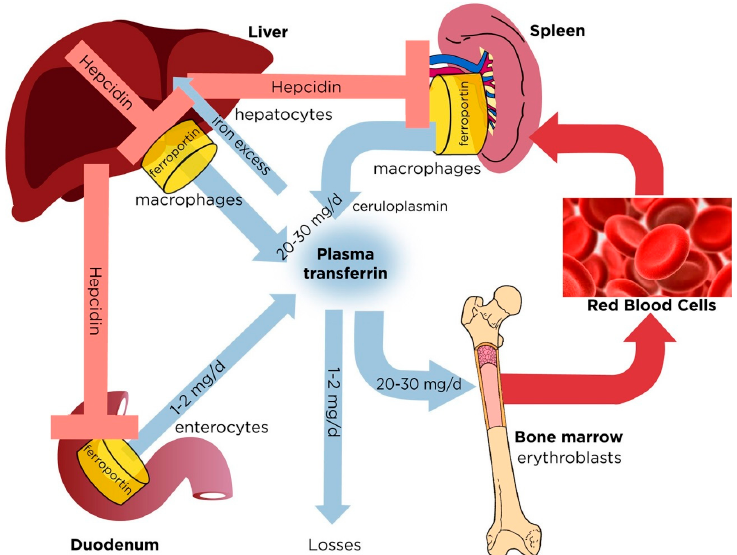
Figure 1. Dynamics of systemic iron balance. Plasma transferrin delivers iron to bone marrow erythroblasts and to other tissues. It contains a very small ( ∼ 0.1%) but highly dynamic fraction of body iron that turns over >10 times/day to meet the iron need for erythropoiesis (20–30 mg/day). The transferrin iron pool is primarily replenished with iron recycled from hepatic and splenic macrophages during erythrophagocytosis of senescent red blood cells. Duodenal enterocytes absorb dietary iron and release small amounts (1–2 mg/day) to compensate for non-specific losses. Hepatocytes store excess of body iron, which can be mobilized to plasma under iron deficiency. Iron efflux to plasma from macrophages, enterocytes or hepatocytes is negatively regulated by hepcidin, a liver-derived peptide hormone that binds to the iron exporter ferroportin and promotes its degradation (Pantopoulos, 2018—with permission) [18].